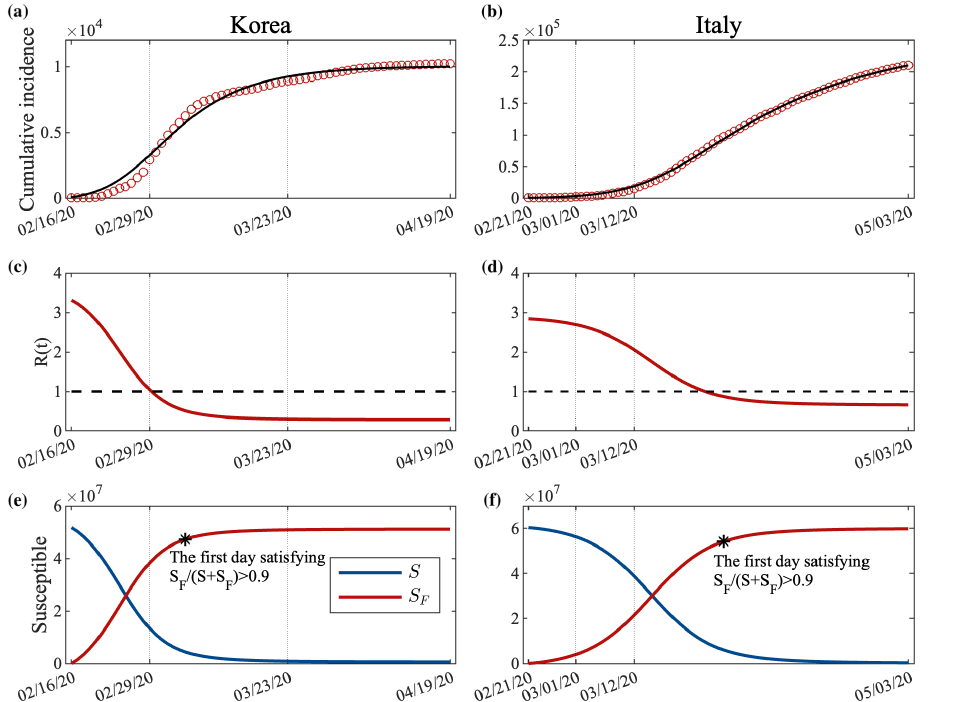
Figure 4. Data fitting result for Korea and Italy: ( a , b ) cumulative confirmed data and behavior- changed model result; ( c , d ) reproductive number derived by the behavior-changed model; ( e , f ) population of normal susceptible and behavior-changed susceptible. The star is the first day satisfying S F / ( S + S F ) >